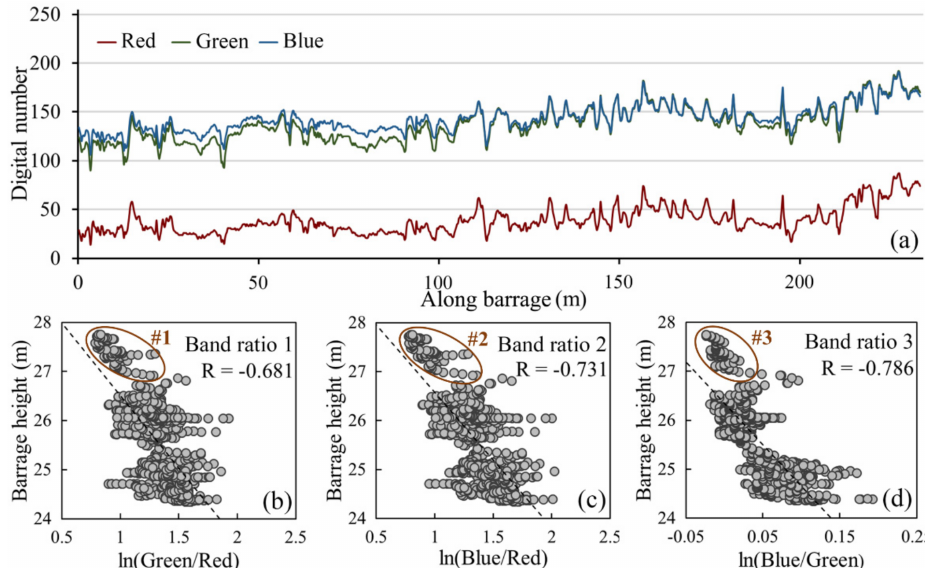
Figure 8. Through-water spectral analysis: ( a ) digital number values of the red, green and blue bands, ( b ) ln(green/red), ( c ) ln(blue/red) and ( d ) ln(blue/green). The ellipses delineate abnormal scatter